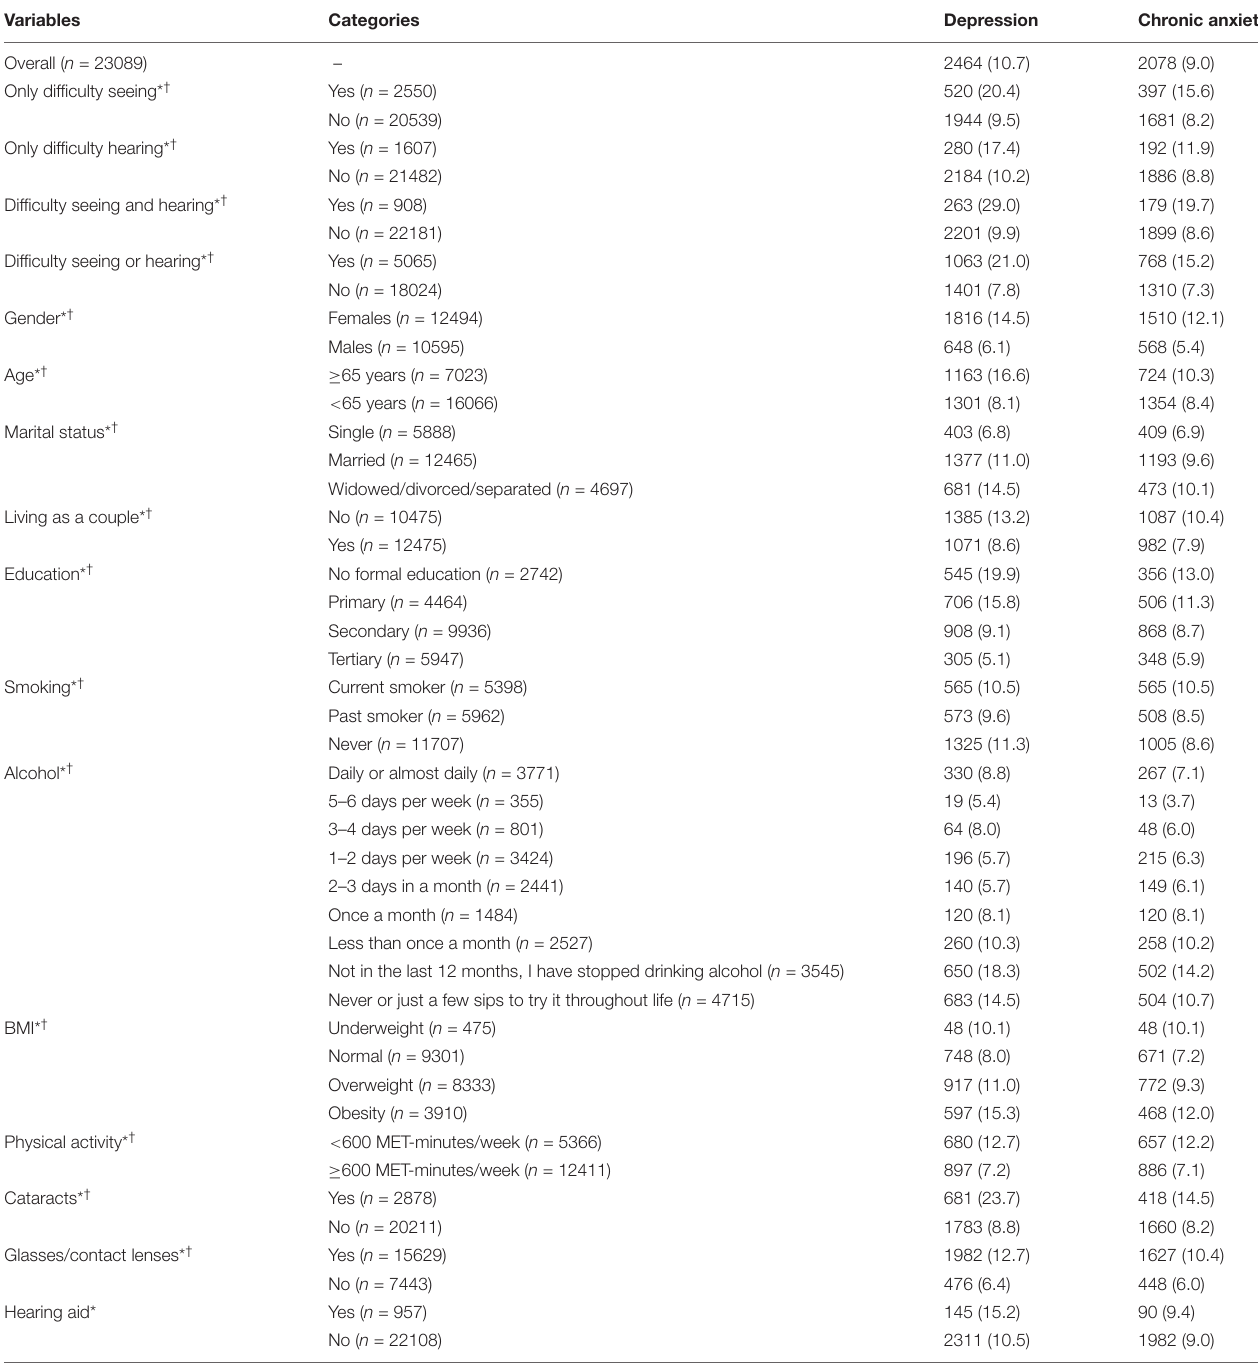
TABLE 1 | Prevalence of chronic anxiety and depression in Spanish adults, by difficulties seeing and hearing and by